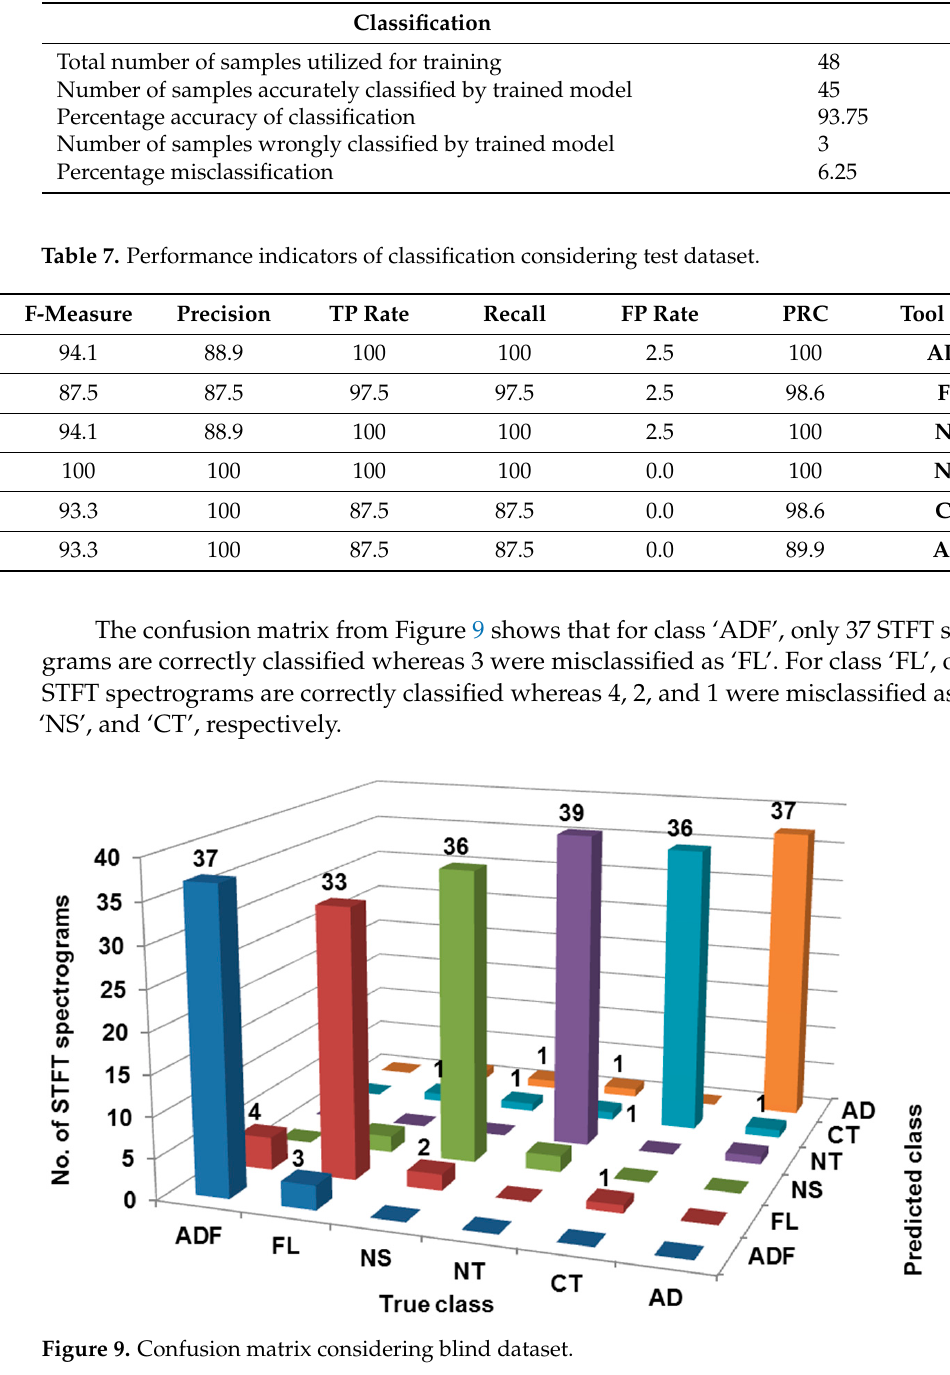
Table 6. Classification results summary considering test dataset.